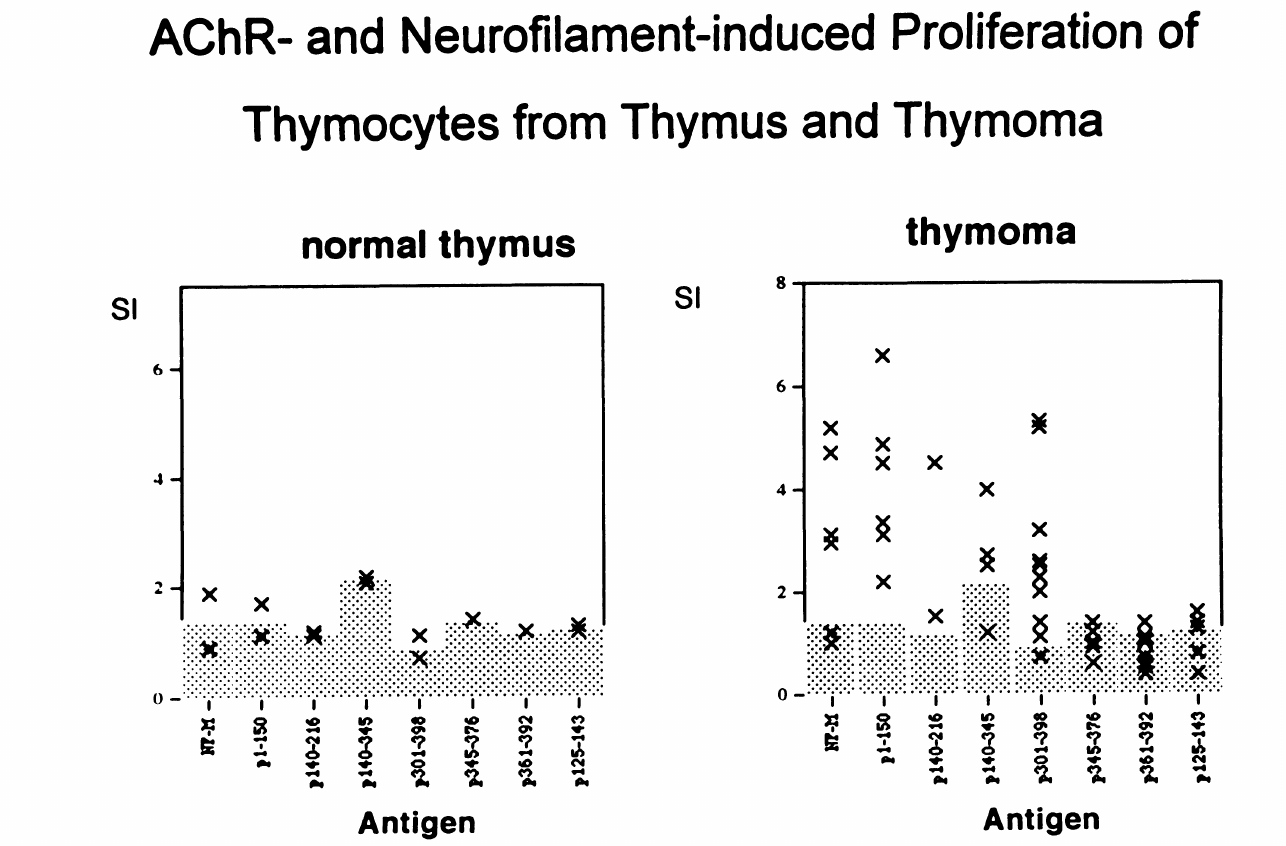
FIGURE 2 Increased frequency of AChR and neurofilament reactive T cells in thymomas. Proliferation of thymocytes from normal thymuses (n 6) and mixed and cortical-type thymomas (n 10) in response to the recombinant human neurofilament fragment aa459-737 (NF-M) and various recombinant fragments and peptides of the AChR alpha subunit. Proliferation was measured by 3H-thymidine incorporation and is given as the stimulation index (SI). Each + represents the mean of six wells per patient and antigen with 5 104